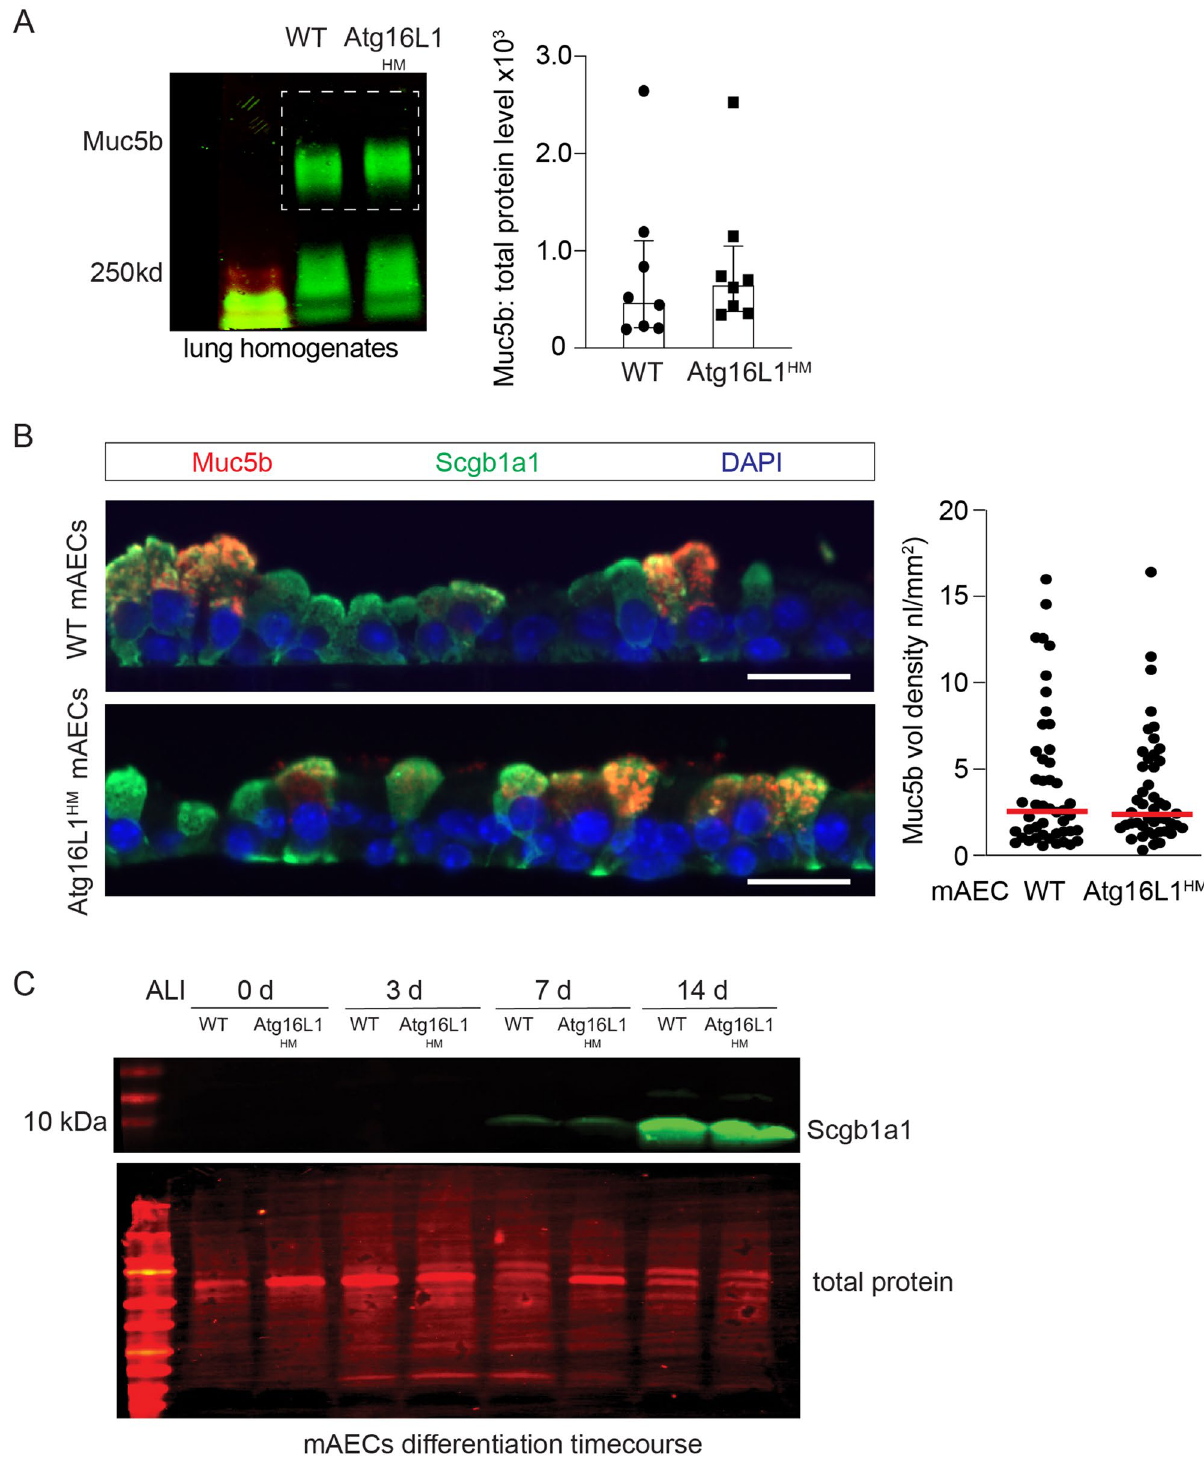
Figure 3. Atg16L1 deficient mice have normal baseline mucin secretion. ( A ) Representative immunoblots with corresponding quantification for Muc5b from lung homogenates from naïve WT and Atg16L1 HM mice. Values normalized to total protein levels (n = 7 mice). Dashed box denotes area of mucin quantification. ( B ) Representative Muc5b (red) and Secretoglobin 1a1 (Scgb1a1) (green) immunostaining from WT and Atg16L1 HM mouse AECs at ALI day 14 with corresponding Muc5b quantification (n = 4 mTEC inserts from 2 independent preps (scale bar = 25 microns). ( C ) Immunoblot for Secretoglobin 1a1 (Scgb1a1) levels from WT and Atg16L1 HM mouse AECs at day 0, 3, 7, and 14 post ALI (blot is representative of two independent mouse AEC preps). Graphs show scatter plots with median bar for mucin immunostaining and scatter plots with median bar and interquartile range for mucin